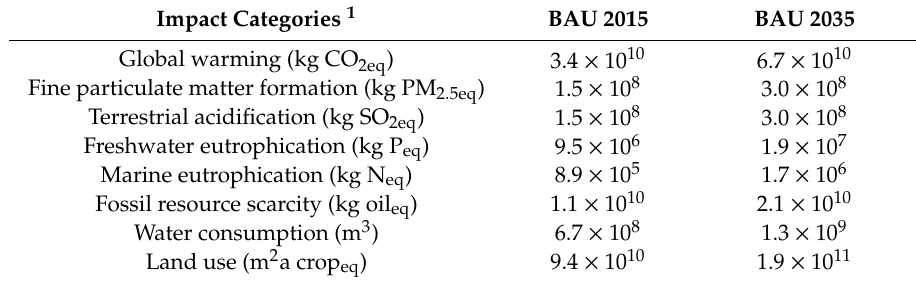
Figure 3. Environmental impacts in the BAU 2015, ICS 2035, PGS 2035, BGS 2035 and INT 2035 scenarios in relation to the BAU scenario, according to the percentage determined in the BAU 2035 scenario. Table 4. Environmental impacts based on critical ReCiPe categories which are associated with biomass cooking activities in the Kisumu County in the BAU scenario in the years 2015 and